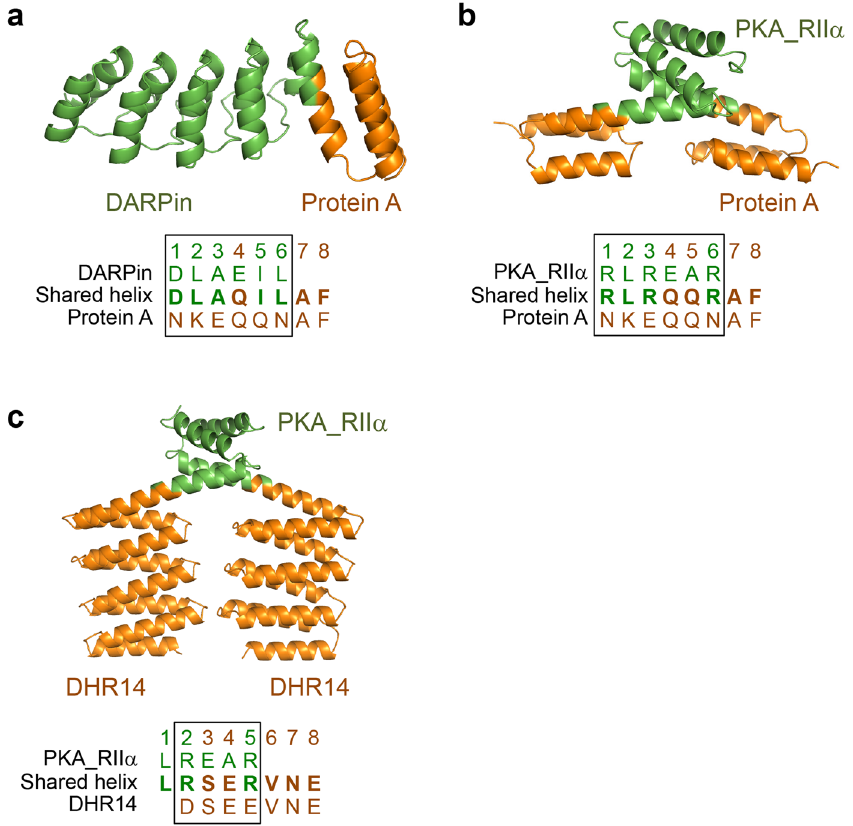
Figure 2. Fusions of DARPin-protein A, PKA_RII α -protein A and PKA_RII α -DHR14 by the shared helix method. ( a ) Crystal structure of the DARPin-protein A fusion protein. The amino acid sequences of the fusion helix area of DARPin, the fusion protein and protein A are aligned and shown below. The shared area of the fusion helix is marked with a box. ( b ) Crystal structure of the PKA_RII α (dimerization domain of the regulatory subunit of protein kinase A)–protein A fusion protein. ( c ) Crystal structure of the fusion protein of PKA_RII α and